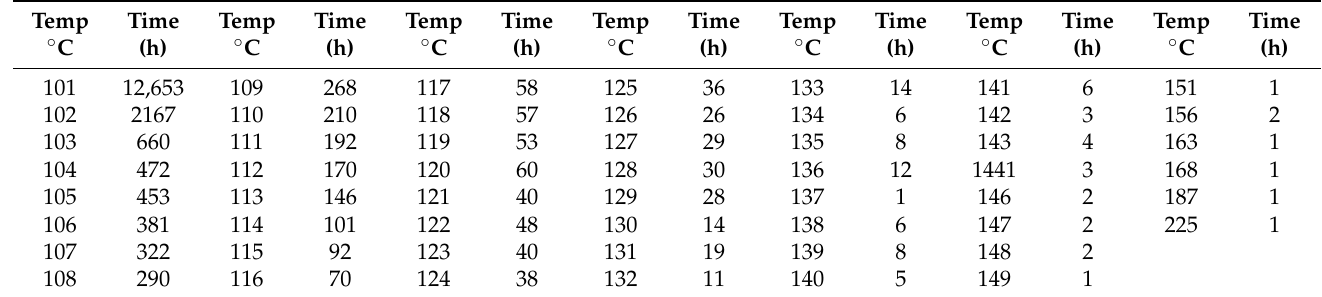
Table 6. Exposure time according to the frequency of conductor temperatures for crisp dynamic rating over a twenty-year period.